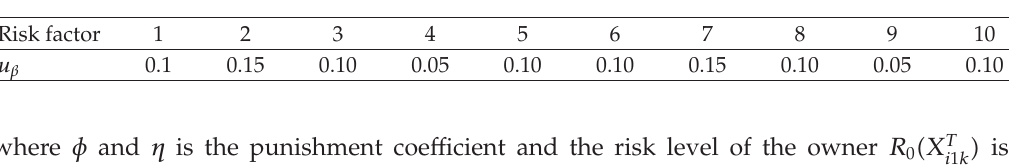
Table 5: The weights of the risk